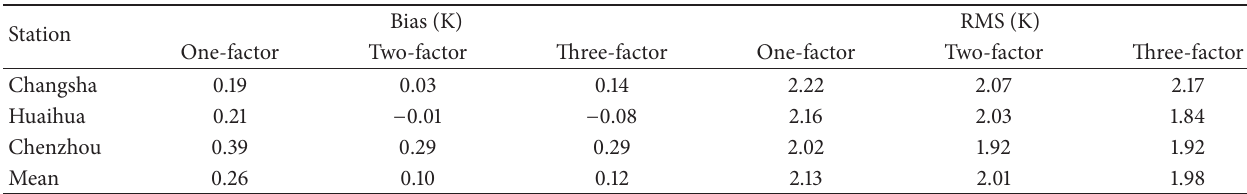
Figure 5: Statistical histograms of the multifactor RTM results at the three stations: (a) two-factor RTM and (b) three-factor RTM. Table 3: Comparison of the biases and RMSs of the differences of one-factor, two-factor, and three-factor RTM-derived 𝑇 𝑚 from the 𝑇 𝑚 truth at the three stations.